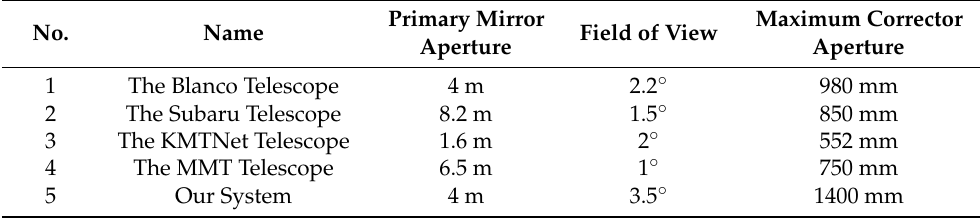
Figure 5. Optical design model.